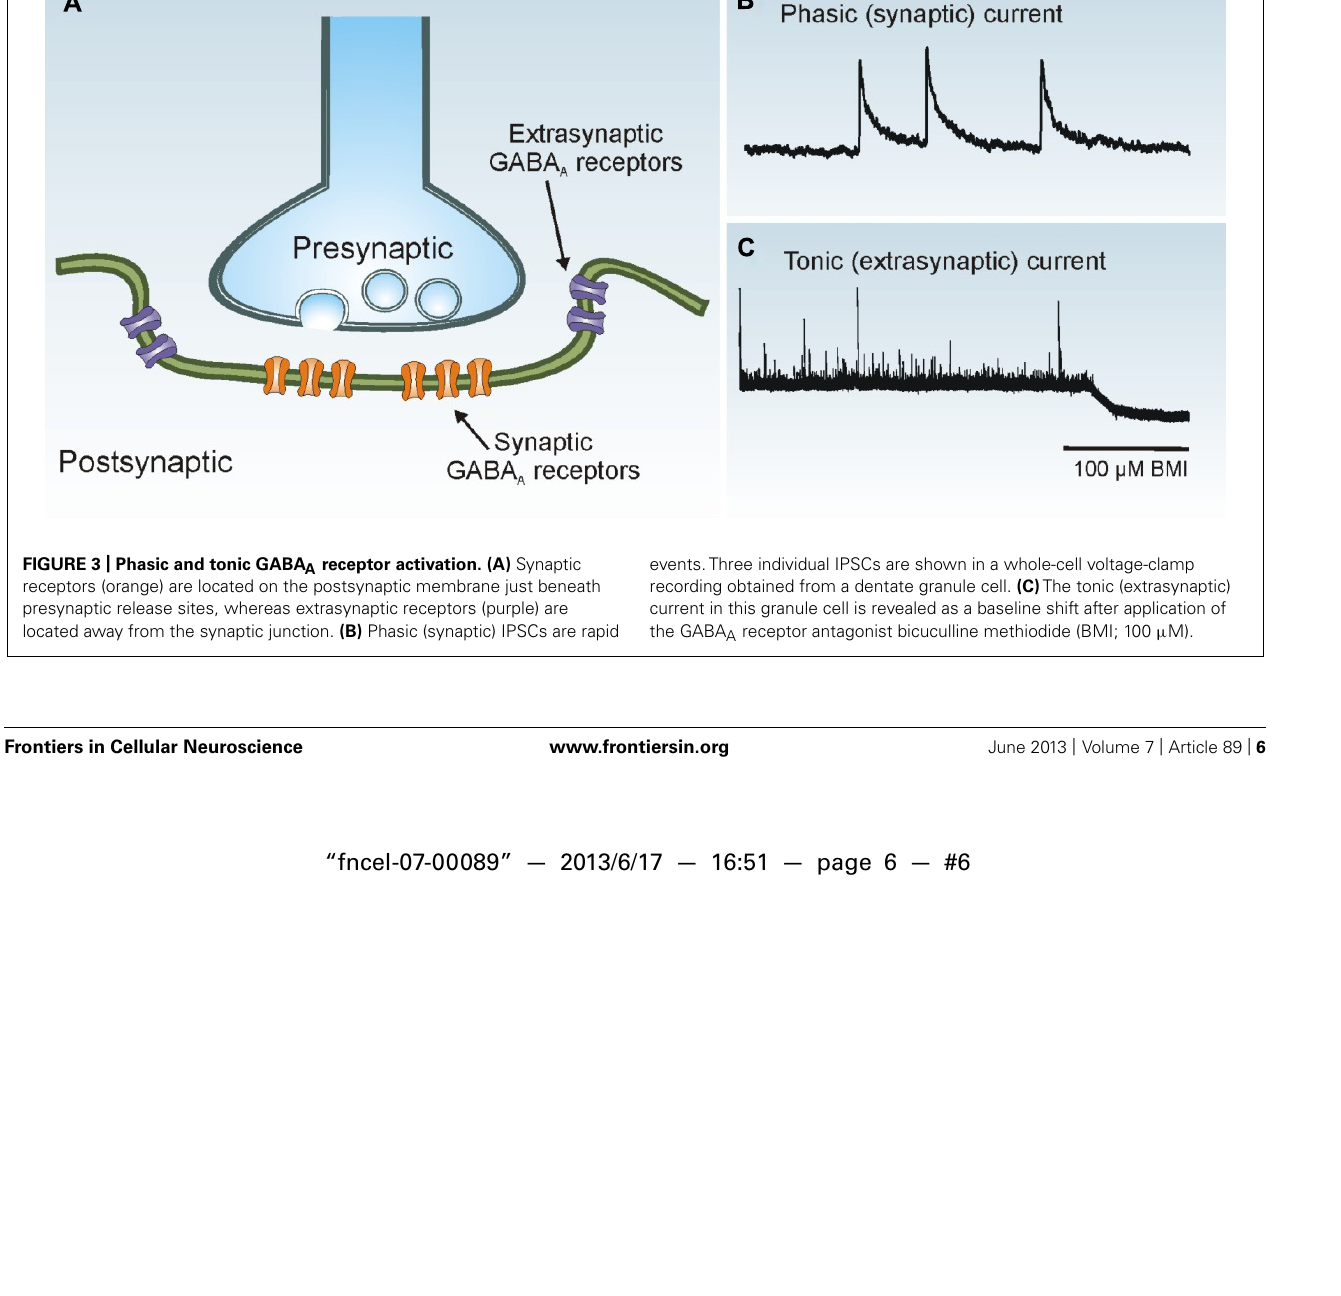
events.Three individual IPSCs are shown in a whole-cell voltage-clamp recording obtained from a dentate granule cell. (C) The tonic (extrasynaptic) current in this granule cell is revealed as a baseline shift after application of the GABA A receptor antagonist bicuculline methiodide (BMI; 100 μ